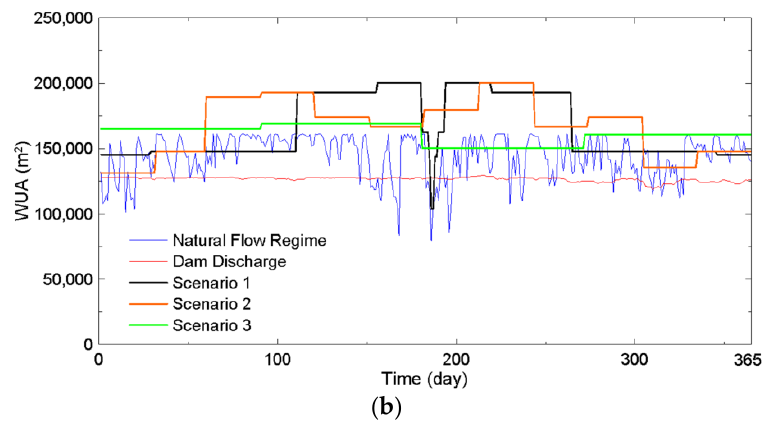
Figure 10. The change of WUA with time: ( a ) Zacco platypus and ( b ) Baetis fuscatus .